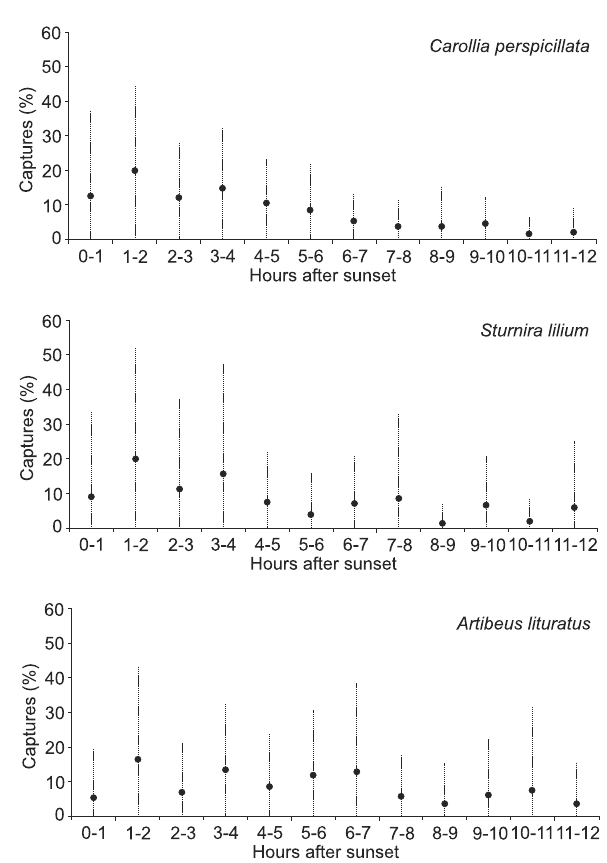
Figure 1. Variation in the number of captures of the bats Artibeus lituratus , Carollia perspicillata , and Sturnira lilium , in relation to one- hour periods of 29 nights, in the Poço das Antas Biological Re- serve, southeastern Brazil. The number of captures of the three studied bat species varied largely among nights. The variability in capturability among nights is represented as mean (center dots) and standard deviation (vertical dashed